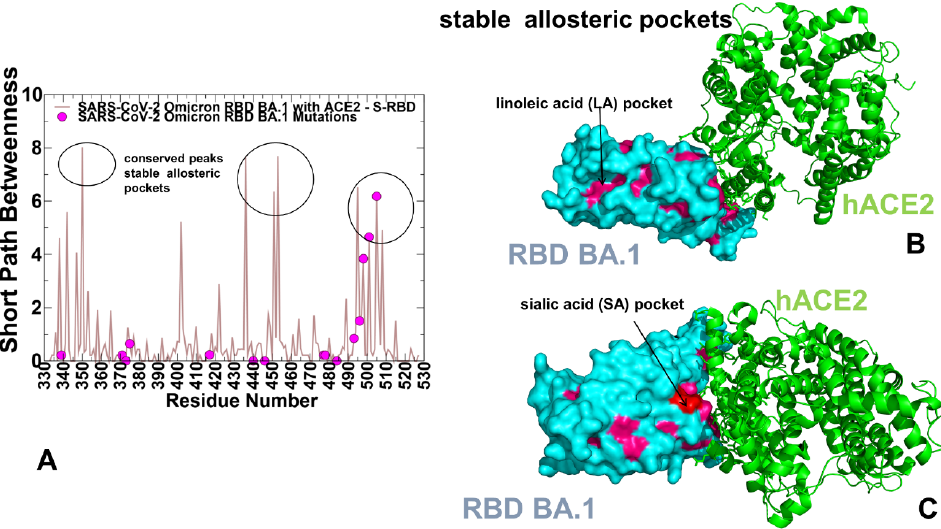
Figure 10. The dynamic network-based analysis of the Omicron RBD BA.1-hACE2 complex. ( A ) The residue-based short path betweenness (SPC) centrality profile. The centrality profiles of the S-RBD residues are shown in light brown lines and the positions of the BA.1 mutations are highlighted in magenta-colored filled circles. ( B ) Structural mapping of the SPC distribution peak clusters unveils potential allosteric binding pockets that are anchored by the allosteric hotspots. The RBD is shown in cyan surface and hACE2 is shown in green ribbons. The RBD pocket regions associated with network-mediating positions (high SPC values) are shown in pink surface. The SPC major peaks correspond the experimentally discovered allosteric binding site of linoleic acid [113]. This validated allosteric pocket is indicated by arrow and annotated. ( C )) Structural mapping of the residues with high SPC values from regions different from the top clusters revealed the experimentally suggested allosteric site for sialic acid [114] (shown in red surface). Other more variable pockets are shown in pink